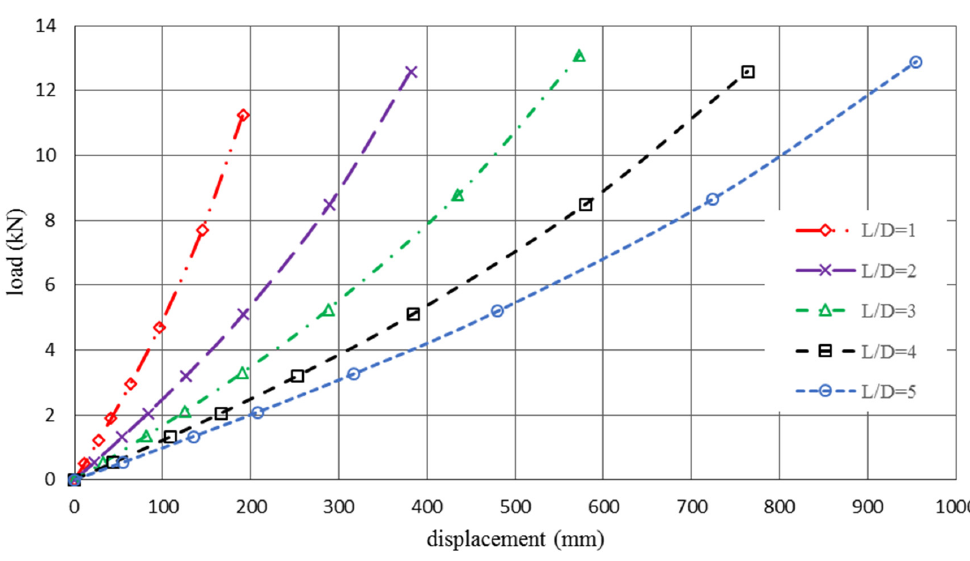
Polymers 2020 , 12 , x FOR PEER REVIEW Figure 9. The load-displacement curve of cellular tubes with di ff erent aspect ratios. Figure 9. The load-displacement curve of cellular tubes with different aspect ratios.